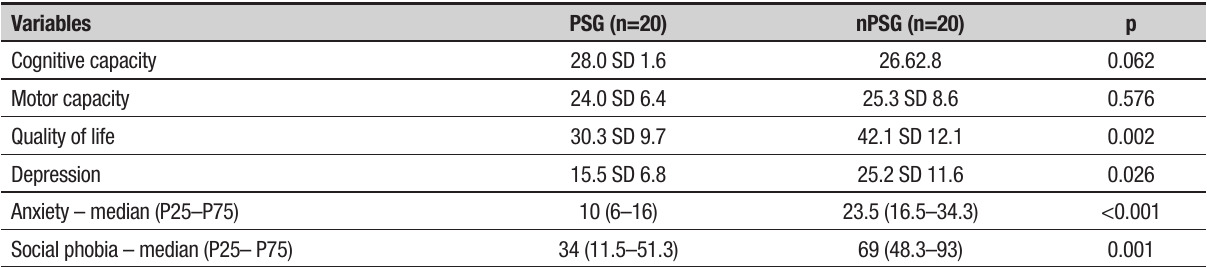
Table 2. Comparison between